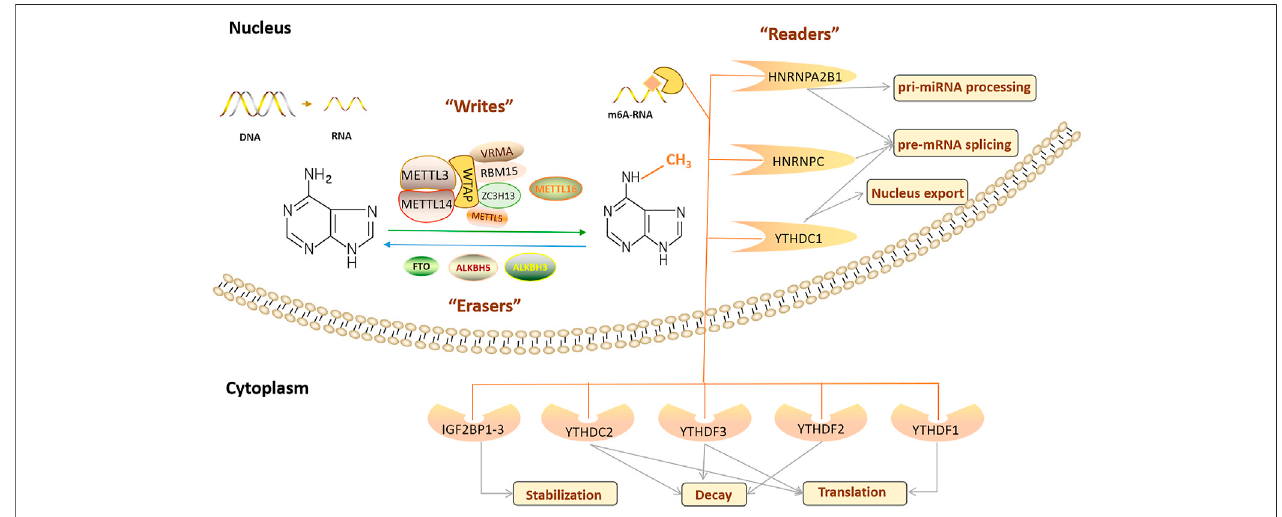
FIGURE 1 | Regulation of the m6A modi fi cation and the function of the m6A